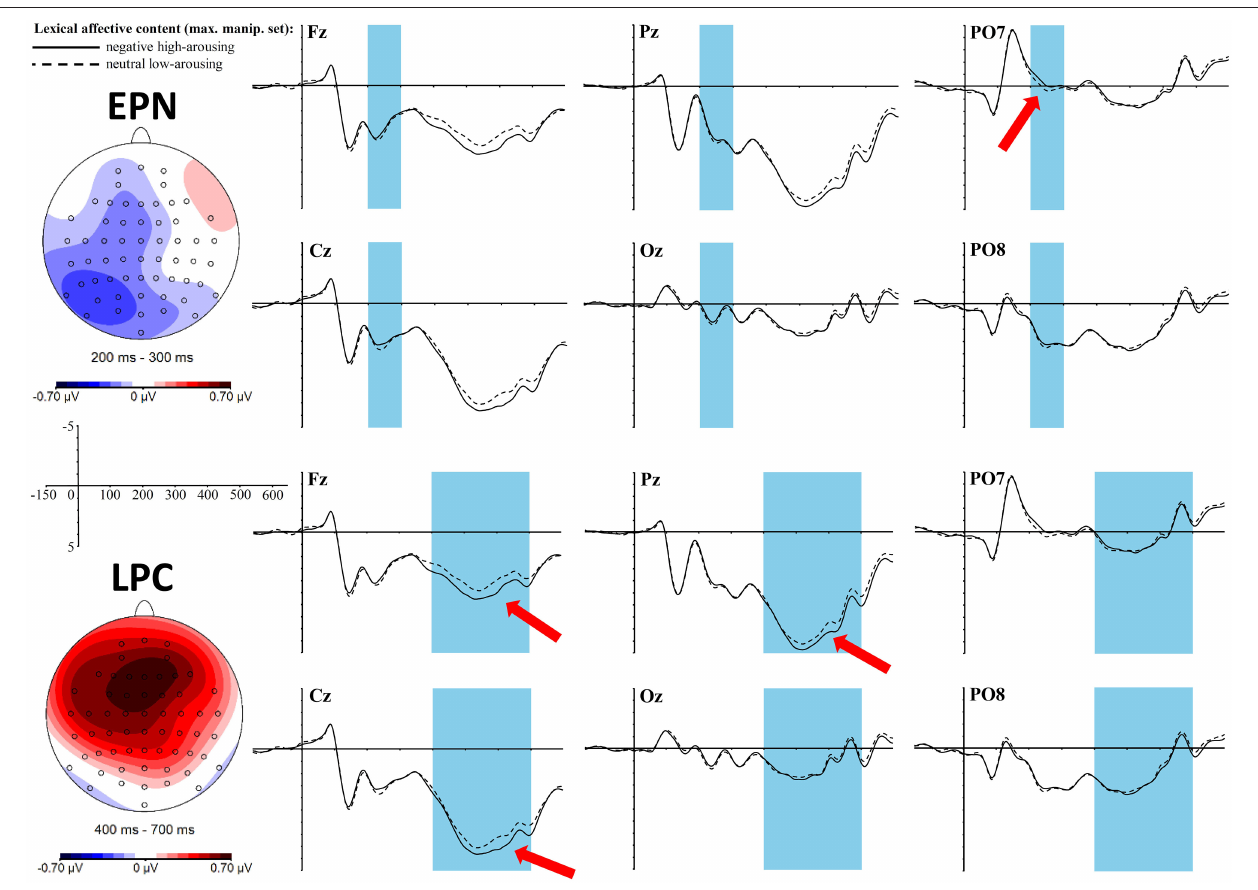
FIGURE 2 | ERP effects of the lexical affective content (top: EPN, bottom: LPC) in the maximally manipulated stimulus set at selected electrode sites. The red arrows indicate at which electrodes the effects are most pronounced. For the topographic maps neutral low-arousing words were subtracted from negative high-arousing